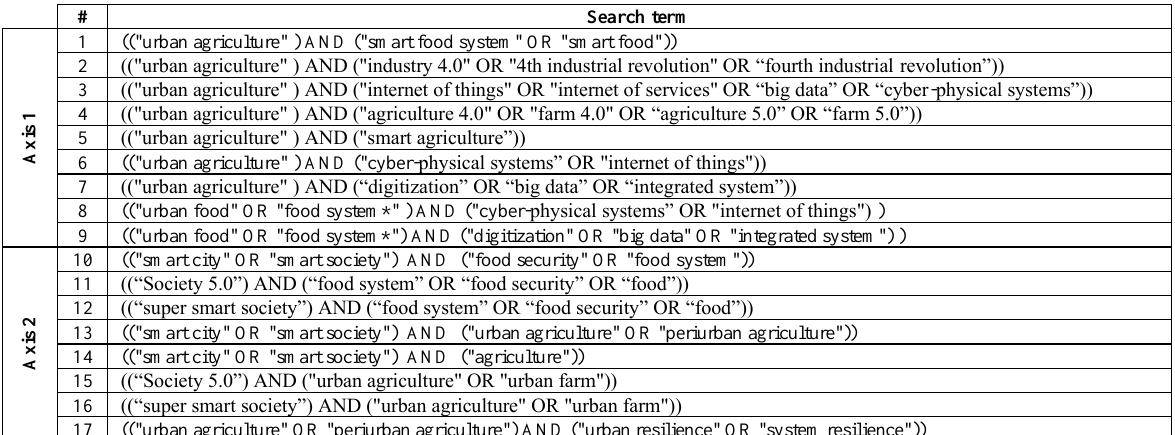
Table 1. Search terms related to each axis considered.